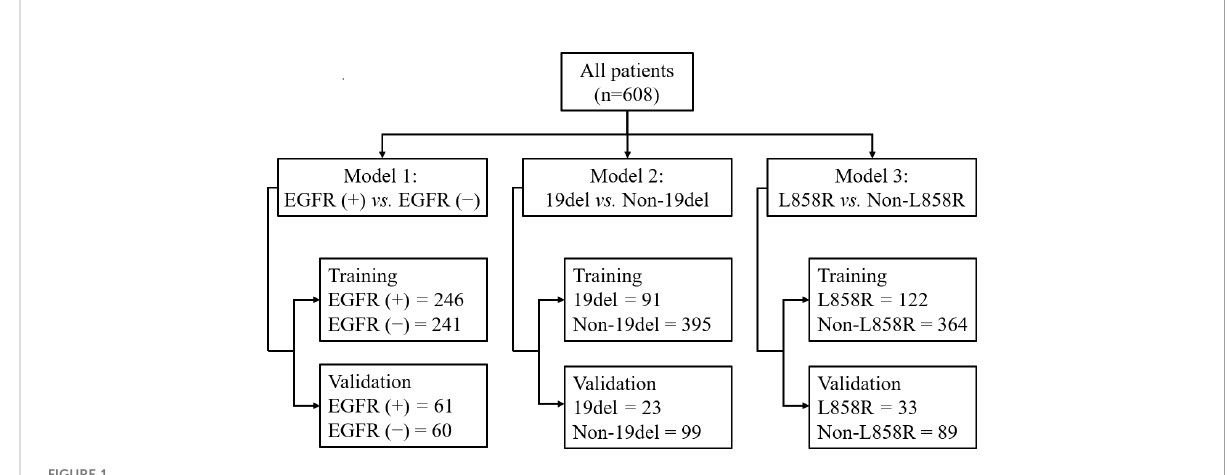
FIGURE 1 The detailed split-sample settings for each